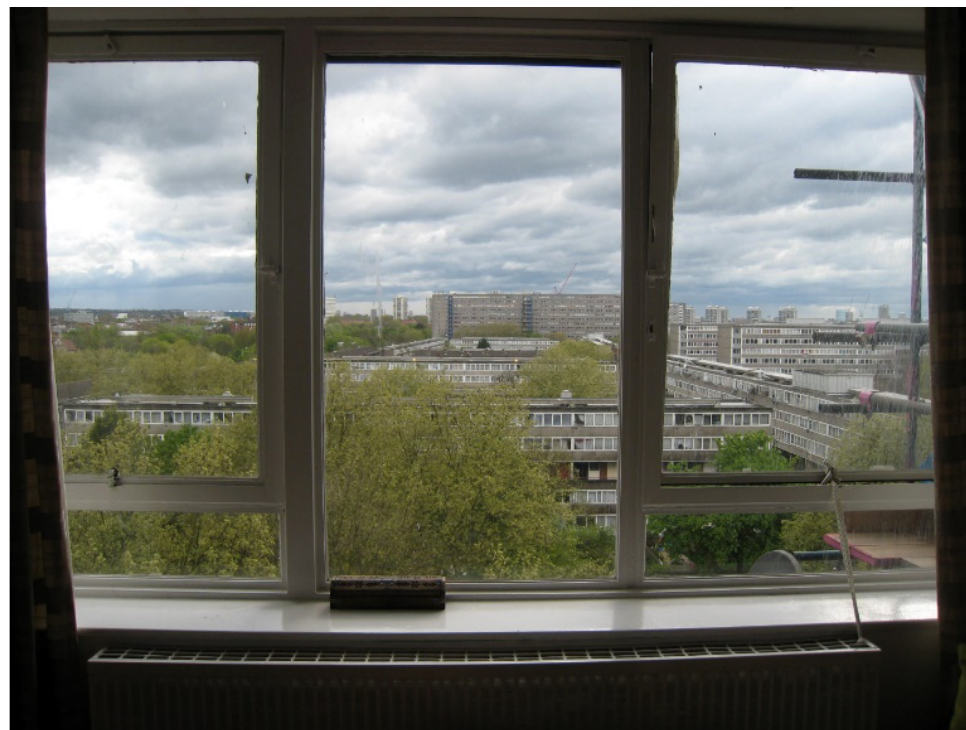
Figure 2. Aylesbury estate: Tenant’s treasured view, 2012. Source: Paul Watt. stereotyping, language and having a criminal record, but not territorial stigmatisation (Murray, 2012). As